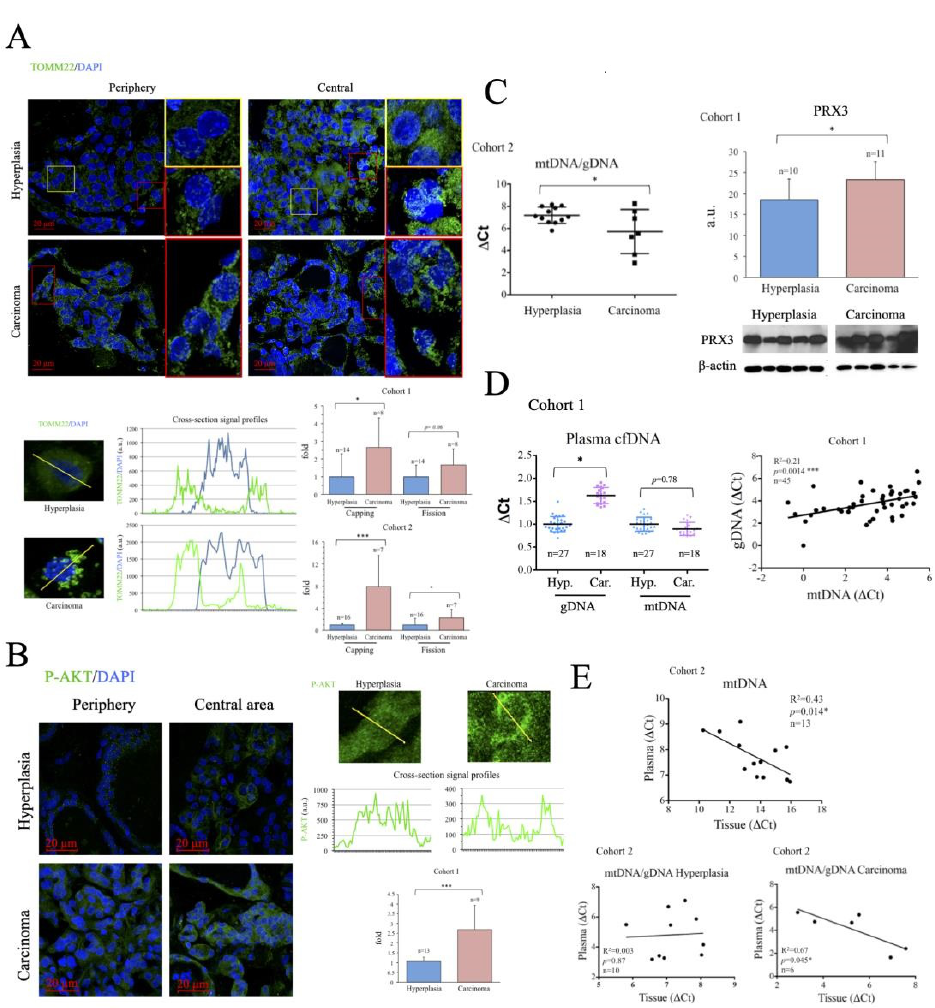
Figure 2. Altered mitochondrial metabolism is more marked in thyroid cancer samples than in hyperplasia samples. ( A ) Immunofluorescence analysis of mitochondrial subcellular distribution using an antibody against TOMM22. Top panel, representative images including zooms of relevant areas. Bottom panels, examples of cross section data acquisition and quantitative analysis. Cross section signal profiles were obtained for TOMM22 (green) and DAPI (blue), the area with DAPI was considered nuclear, the 5 cytosolic adjacent data points were considered peri-nuclear, the ratio of these on both nuclear sided was defined as capping . The standard deviation of all the cytosolic data points for TOMM22 per cell was used as a surrogate marker of mitochondrial fission. ( B ) Immunofluorescence analysis of p-AKT using a specific antibody. Left panel, representative images. Right panels, examples of cross section data acquisition and quantitative analysis. Cross section signal profiles were obtained for p-AKT (green) and DAPI (blue), the area with DAPI was considered nuclear. The 5 data points closest to the cell edges were considered informative of membrane localization, and the ratio of the membrane values and the average value for all the cytoplasmic signal was calculated for each cell. ( C ) Left panel, qPCR analysis of mtDNA in thyroid tissue. Right panel, thyroid tissue PRX3 western blot data analysis. ( D ) qPCR analysis of mtDNA in plasma samples. Left panel, cfDNA levels in plasma samples. Right panel, correlation and linear regression of mtDNA and gDNA levels in plasma samples. ( E ) Correlation and linear regression of mtDNA levels in plasma and thyroid tissue samples determined by qPCR. Data are mean ± standard deviation (SD). *, p < 0.05; ***, p ≤ 0.005.